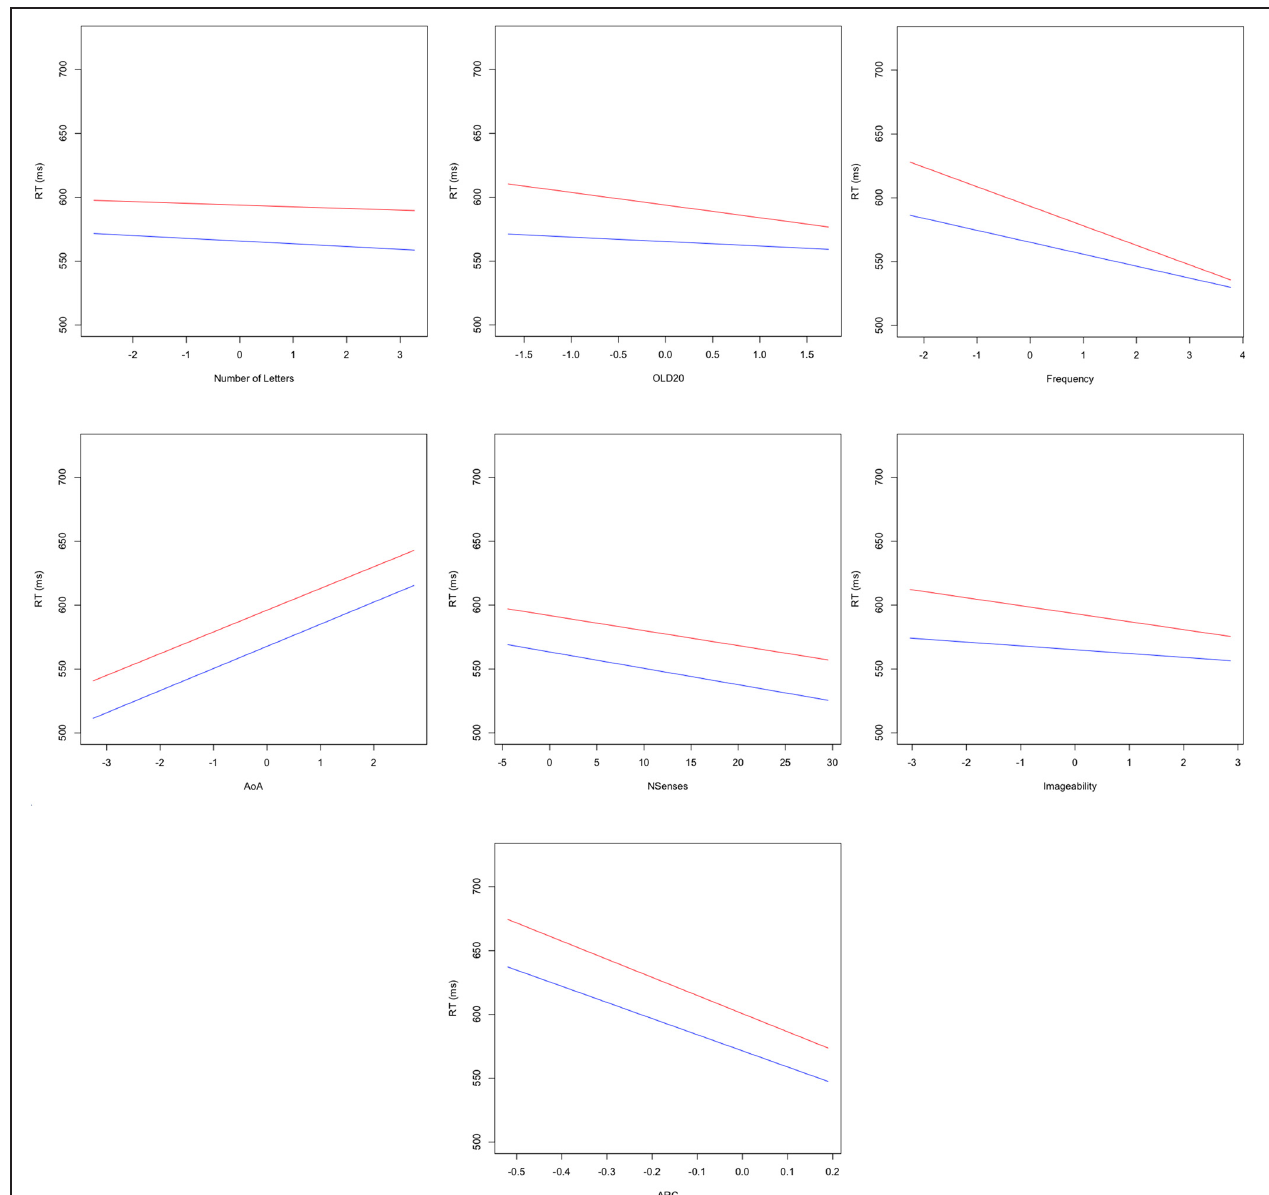
FIGURE 3 | Plots of fixed effects from a model fitted to LDT reaction times to 3723 words for early (less than block 28; red) and late (greater than block 28 but excluding the shortened block 57; blue) blocks. Note: Length, number of letters (centered); OLD20, mean levenshtein distance to